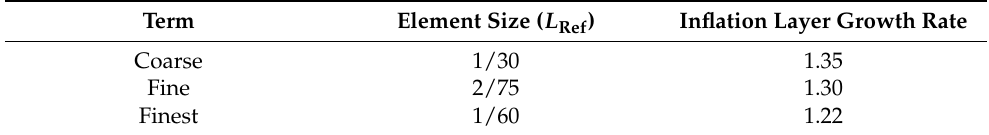
Table A1. Mesh category specifications.